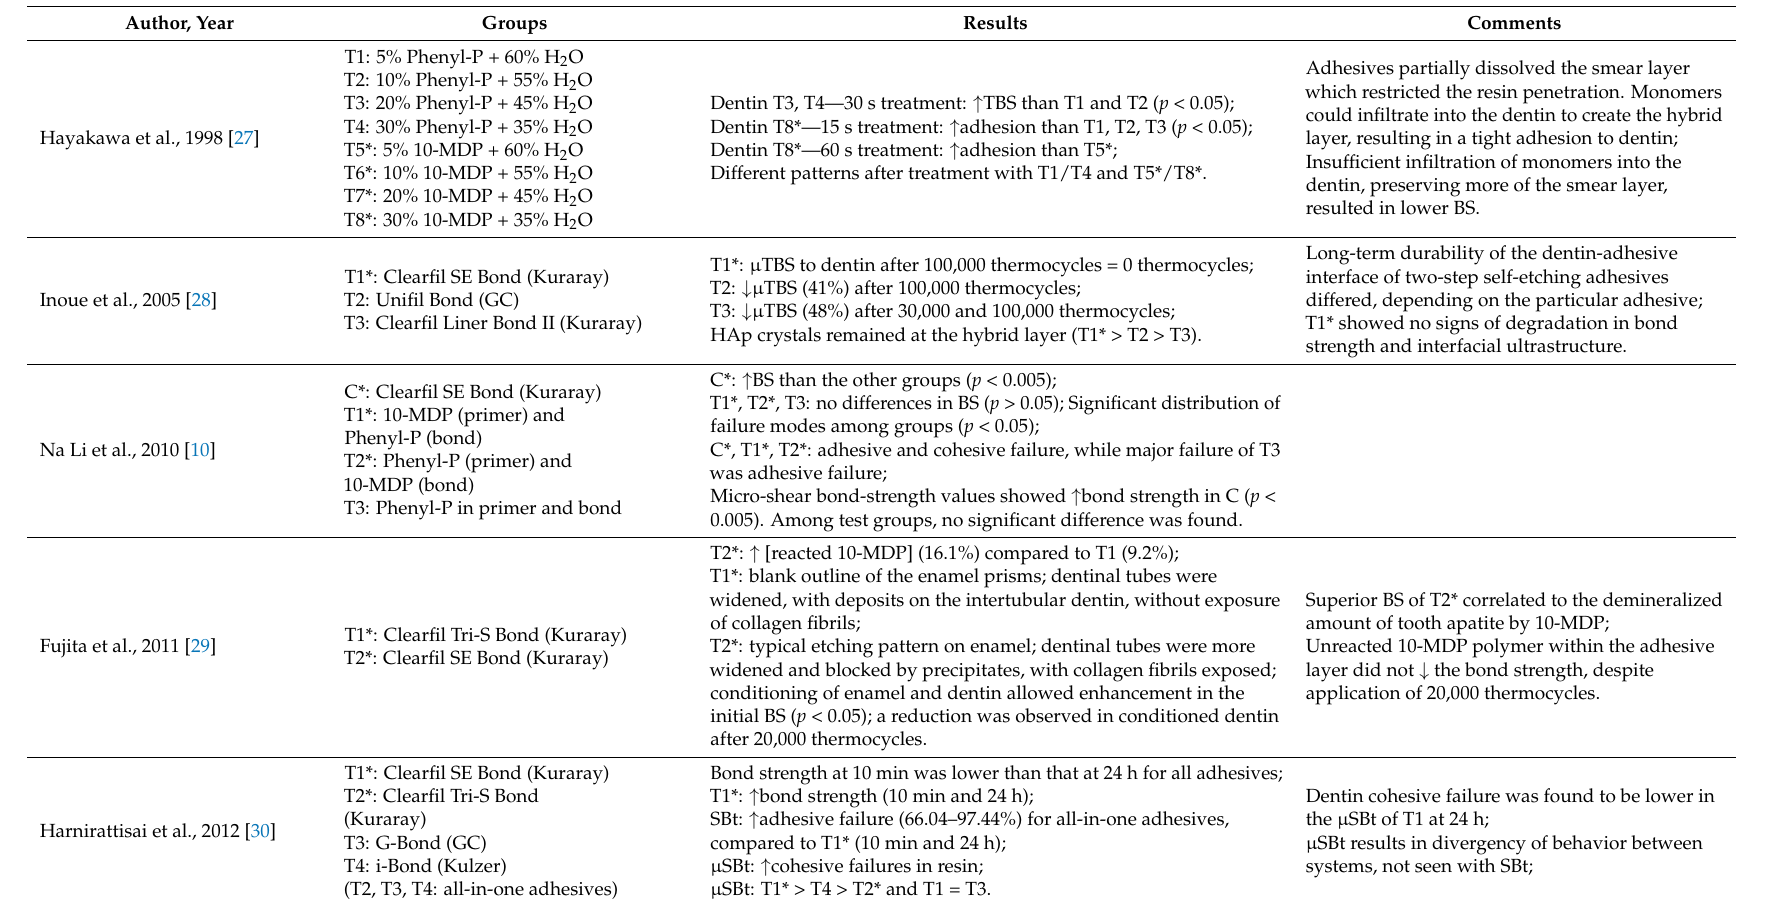
Table 6. Adhesive